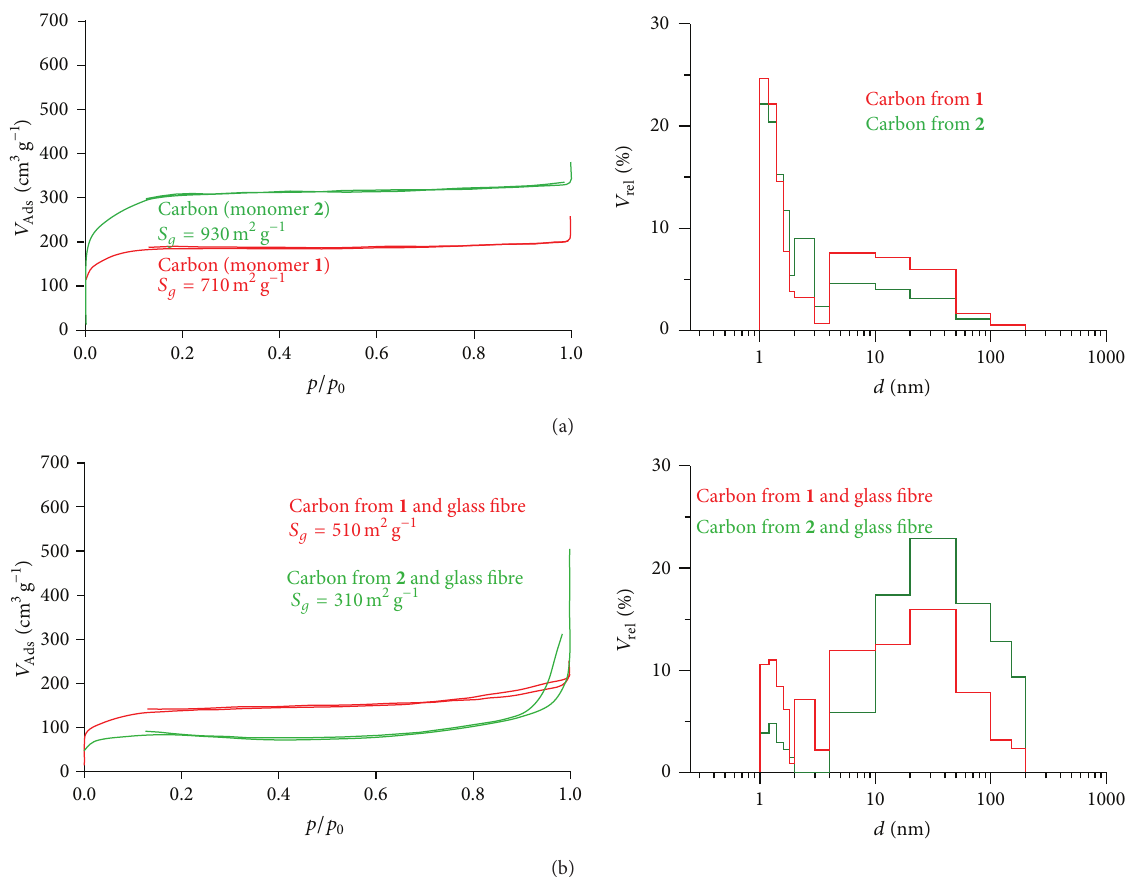
Figure 4: Nitrogen-sorption-isotherms and pore-size distribution plots (insets) of carbon from (a) from template-free TP by thermal induction AND (b) at glass fibre template by thermal